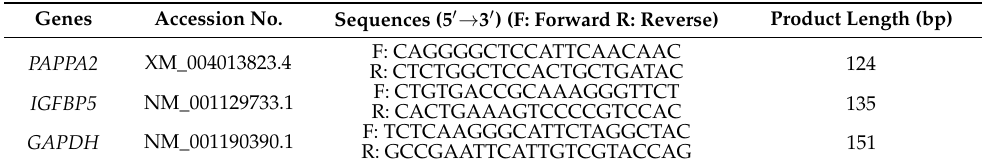
Table 1. Primers